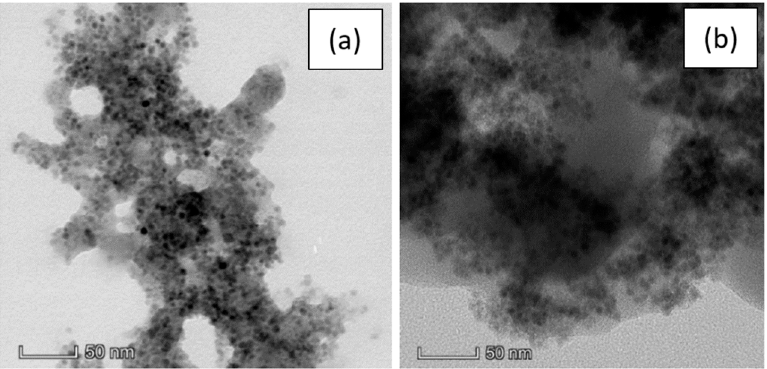
Figure 4. TEM images of a pSi microparticle after SPIONs decoration at 50 nm scale in: ( a ) PBS; ( b ) water.